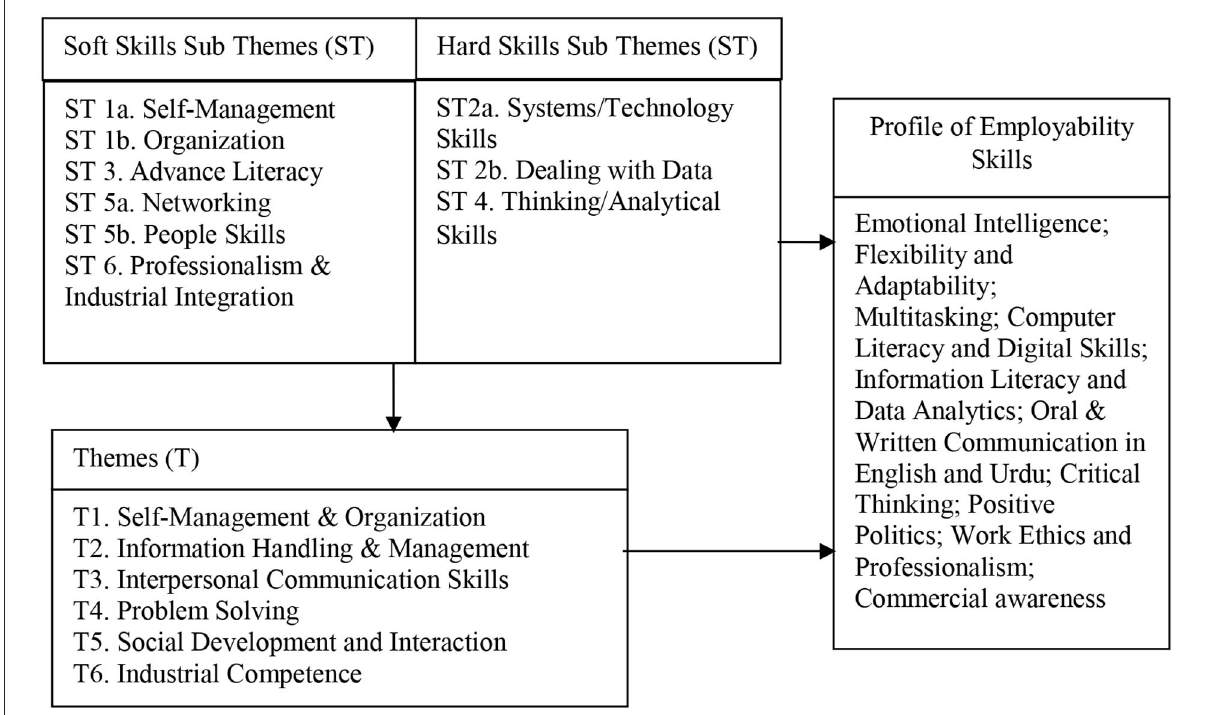
FIGURE1 Conceptual framework exhibiting the relationship between generic skills’ themes, sub-themes, and profile of hard and soft employability